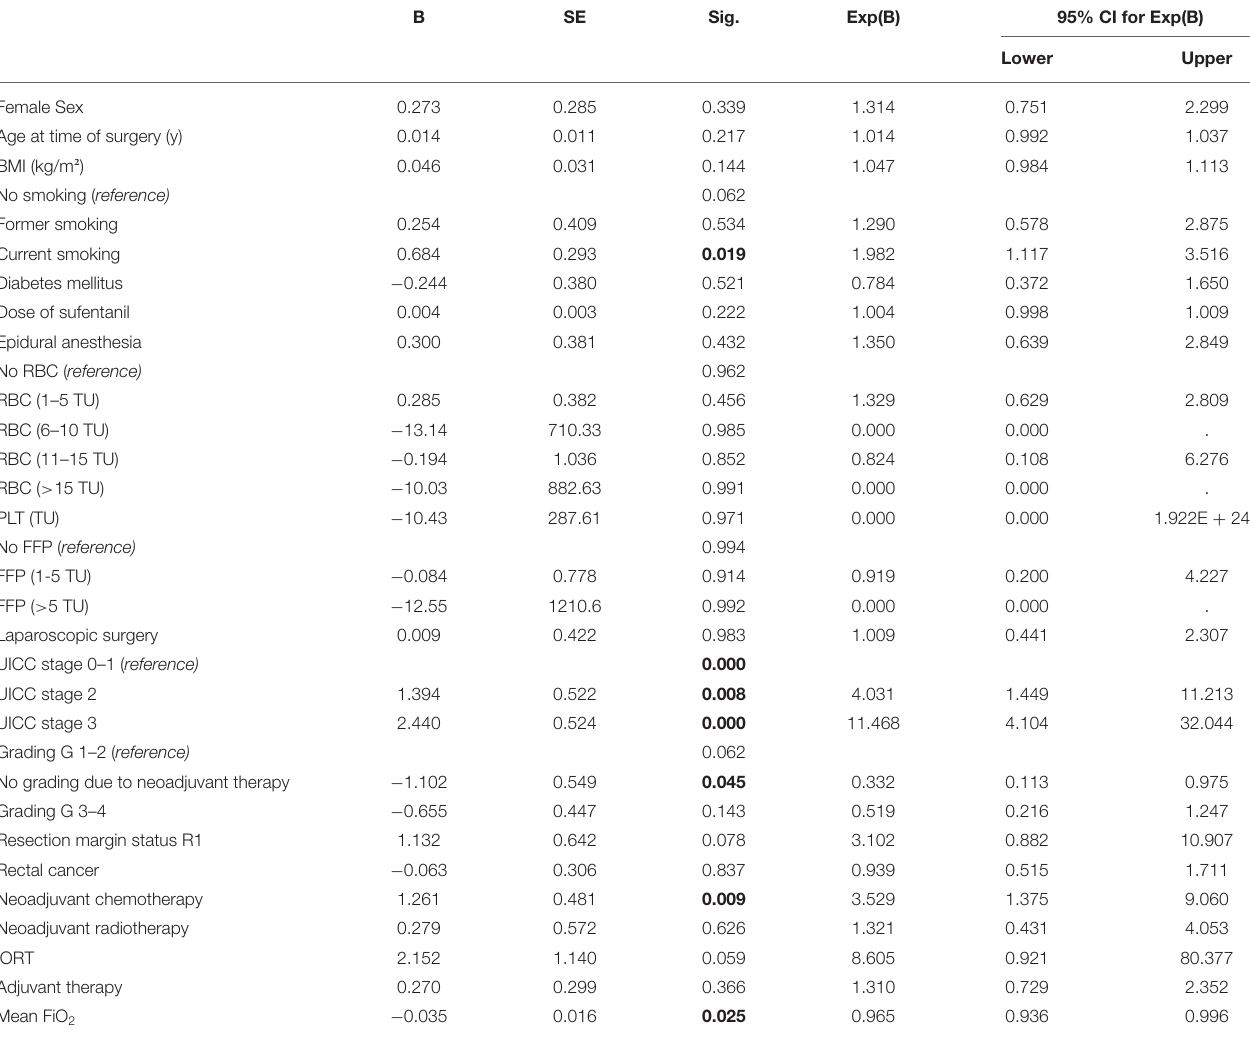
TABLE 2 | Independent effects of FiO 2 on recurrence-free survival in patients with CRC.